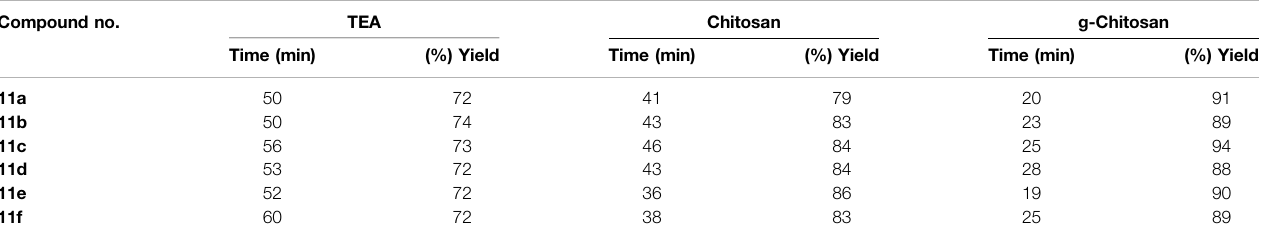
TABLE 3 | Comparison of synthesis of thiadiazolylcoumarines 11a – f under USI using different basic catalysts on the time of reaction and the yield% of the products. Compound no.